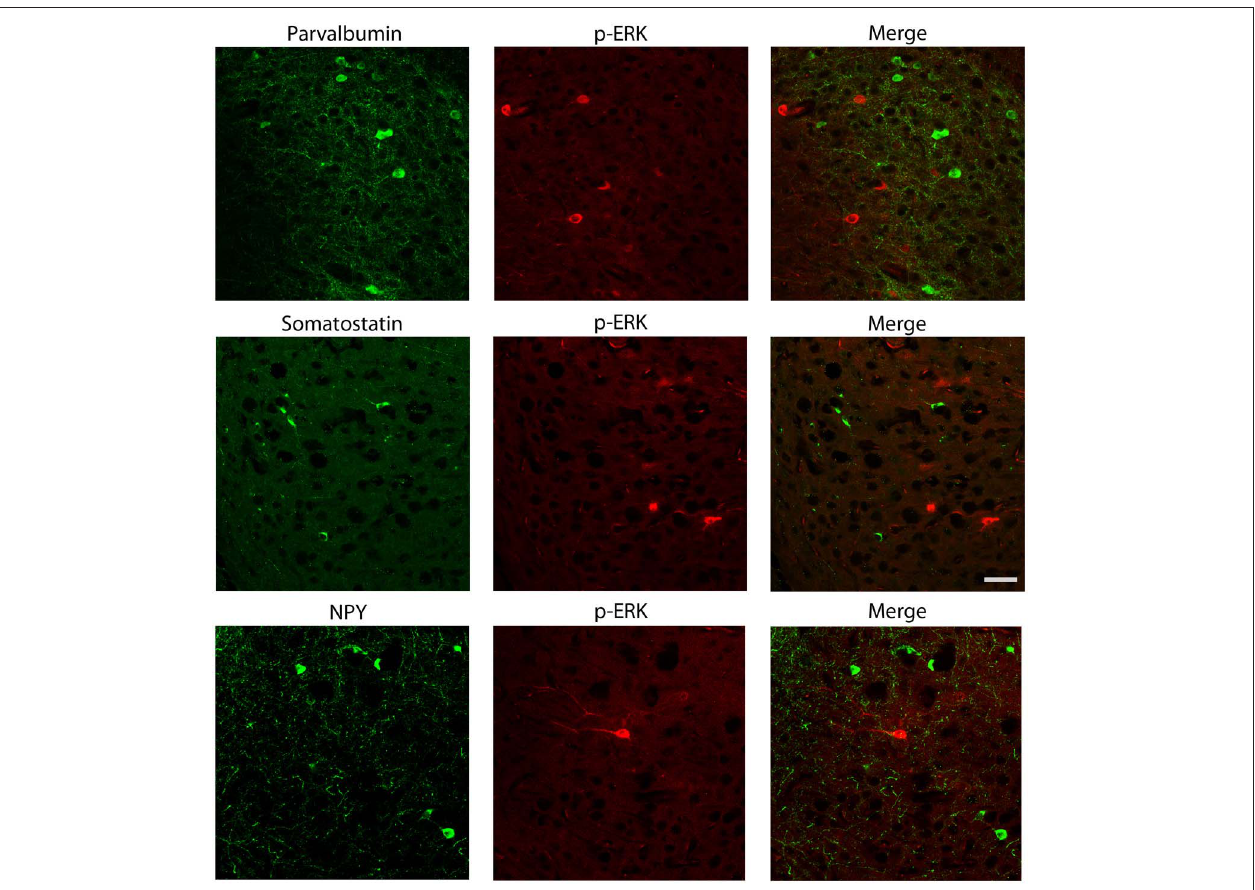
somatostatin ( middle panels) or neuropeptide Y (NPY; bottom panels) did not co-localize with p-ERK1/2-immunopositive cells. Scale bar: 25 μ